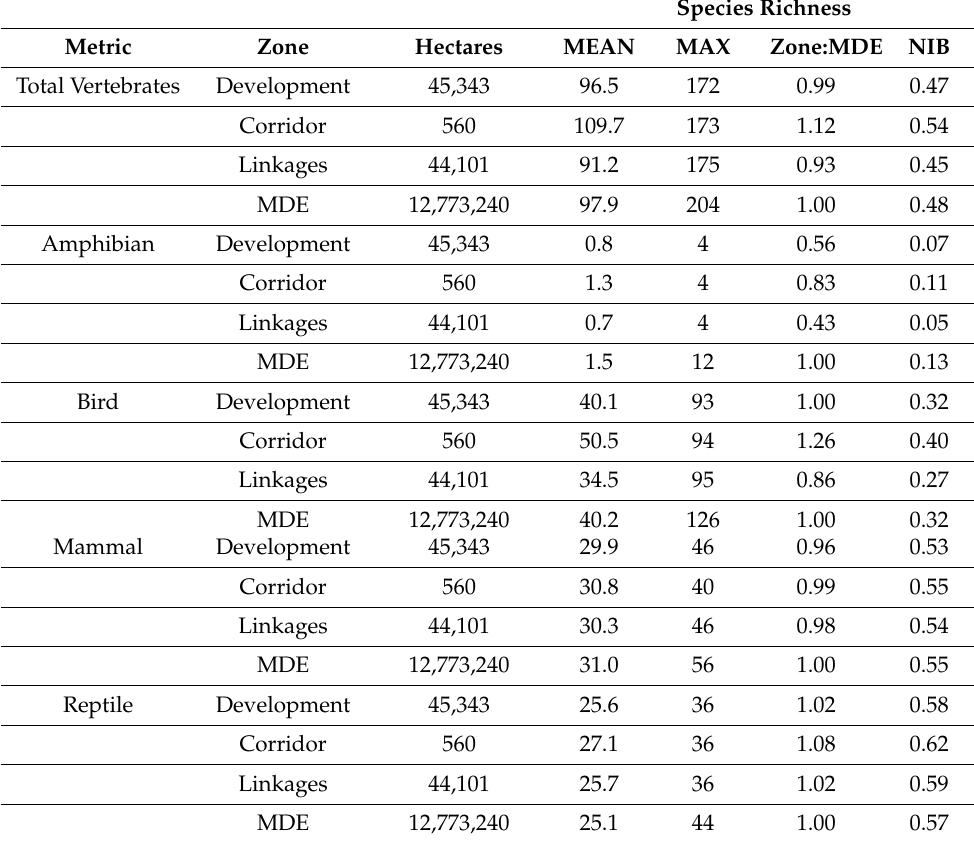
Table 3. Biodiversity metric analysis within multiple management zones of the Apple Valley Multi- Species Habitat Conservation Plan area (MSHCP). Zones include Development, Mojave River Corri- dor, Linkages, and Mojave Desert Ecoregion (MDE). Zone: MDE is ratio of mean species for a zone to the mean species for the MDE. Normalized Index of Biodiversity (NIB) is mean species richness within the zone divided by the maximum number of species found within the MDE. Species Richness Metric Zone